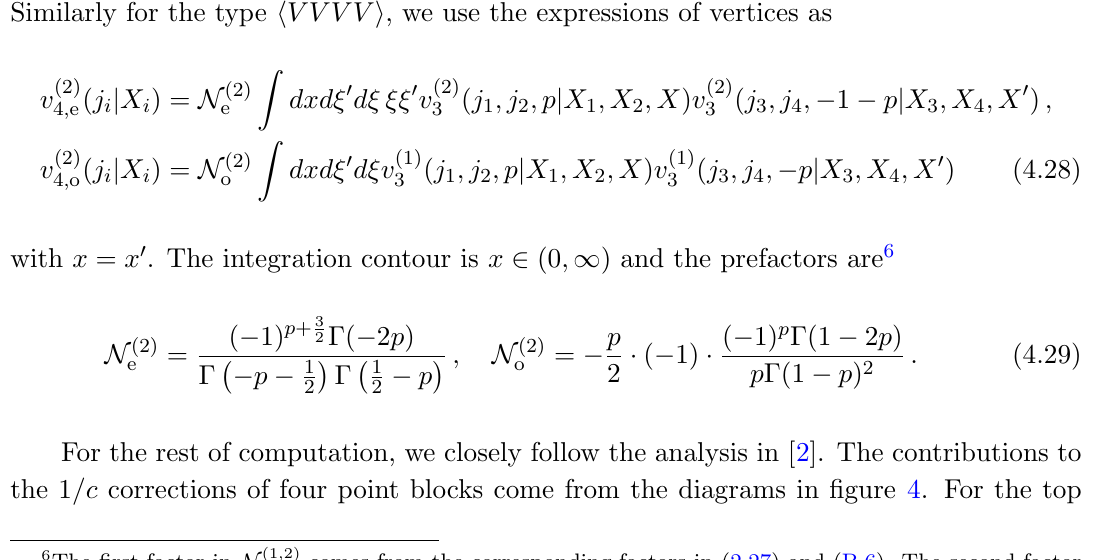
The leading order expressions of four point blocks for h W V V W i are computed in